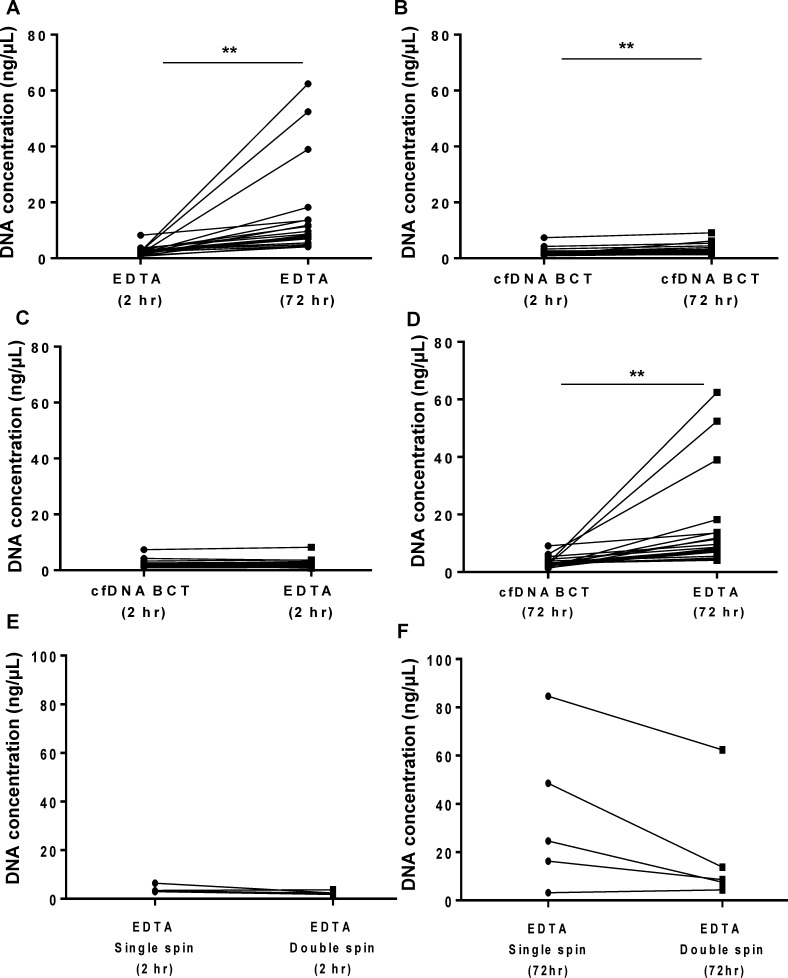
Plasma processing method comparison.Whole blood was collected from 20 NSCLC patients and processed using various tube types, incubation times and centrifugation steps. A subset of these patients (n = 5) had whole blood processed to assess a single vs. double centrifugation step. DNA was measured using the ABI TaqMan® RNase P Detection Reagent Kit A: Blood was collected using EDTA blood collection tube (EDTA) and processed after 2 hr or 72 hr. B: Blood was collected using cell free DNA blood collection tube (cfDNA BCT) and processed after 2 hr or 72 hr. C: Blood was collected using EDTA or cfDNA BCT tubes and processed after 2 hr. D: Blood was collected using EDTA or cfDNA BCT tubes and processed after 72 hr. E: Blood collected in EDTA tubes after 2 hr incubation and processed using either single or double centrifugation. F: Blood collected in EDTA tubes after 72 hr incubation and processed using either single or double centrifugation. Results are displayed for each patient. Statistical analysis was performed using a paired Student’s t-test where; **p<0.01.